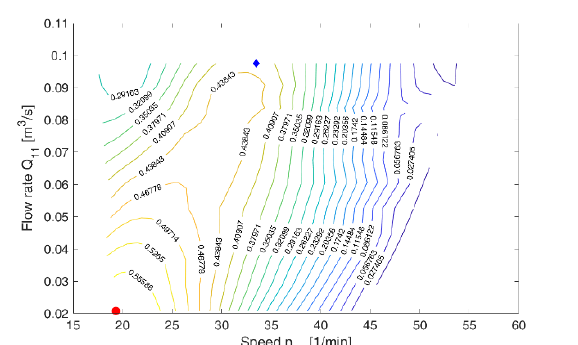
Fig. 13. Q 11 n 11 diagram for configuration, bucket -20 and channel edge position -40 for different flow rates.